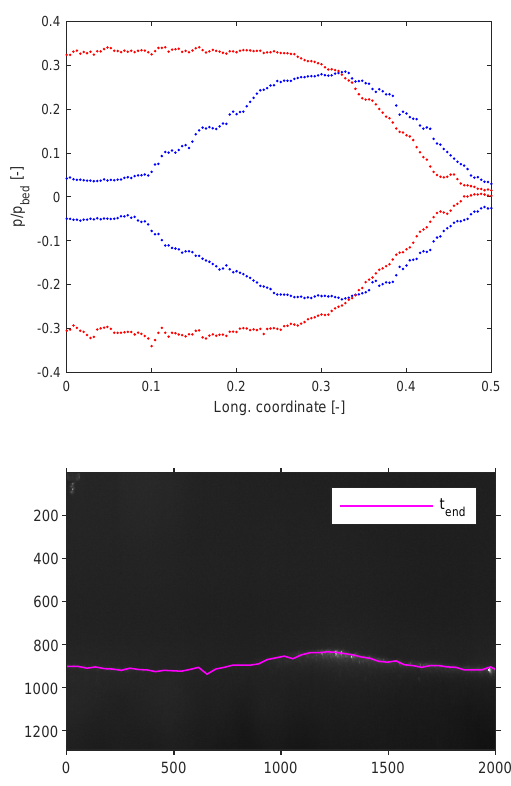
Fig. 6 : Results for a flexible and rigid plate. Top panel: Pressure envelopes of minimum and maximum values for the flexible and the sti ff plates (run n. 163 and 164). Bottom panel: Heap profile at the end of run n.163 where the flexible plate was used (where 1800 pixels correspond to 10